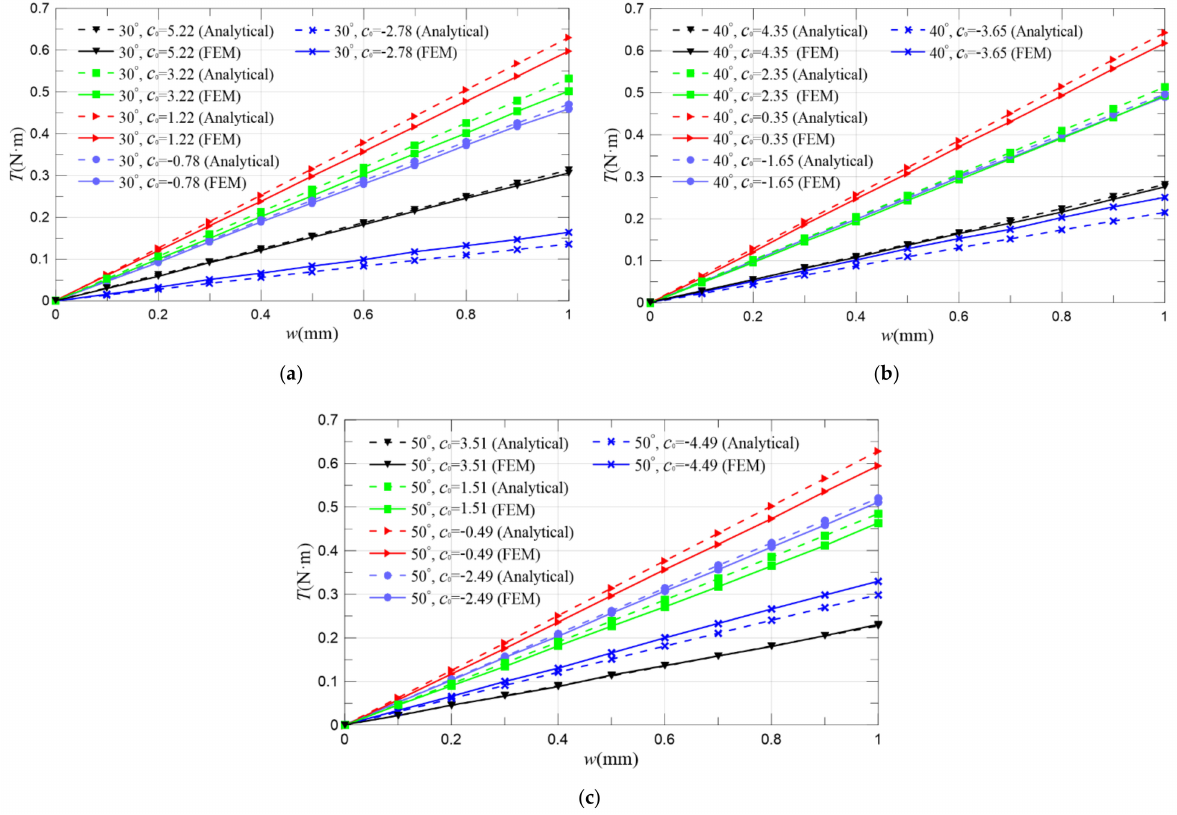
Figure 14. Verification for the parameter optimization with FEM simulation: ( a ) influence of c 0 on the torque–displacement characteristics with α = 30 ◦ ; ( b ) influence of c 0 on torque–displacement characteristics with α = 40 ◦ ; ( c ) influence of c 0 on torque–displacement characteristics with α = 50 ◦